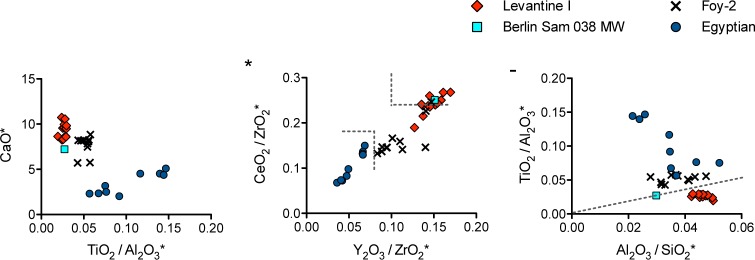
Analysis of the silica sources of the natron-type glasses from Samarra.(A) CaO versus the ratio of TiO2 / Al2O3; (B) CeO2/ZrO2 versus Y2O3/ZrO2; (C) TiO2/Al2O3 versus Al2O3/SiO2.